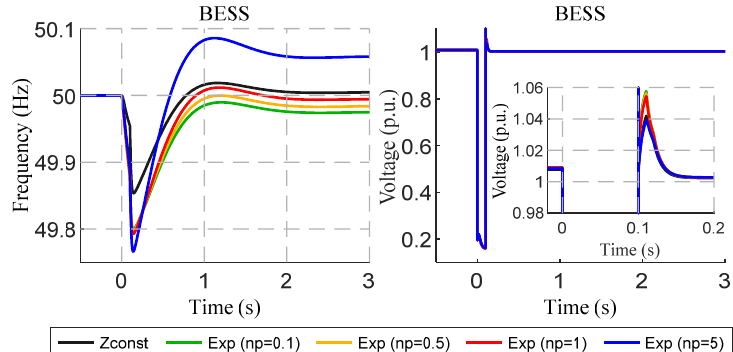
Figure 7. BESS power converter synthetic frequency and terminal voltage: exponential load model active power coefficient sensitivity analysis.